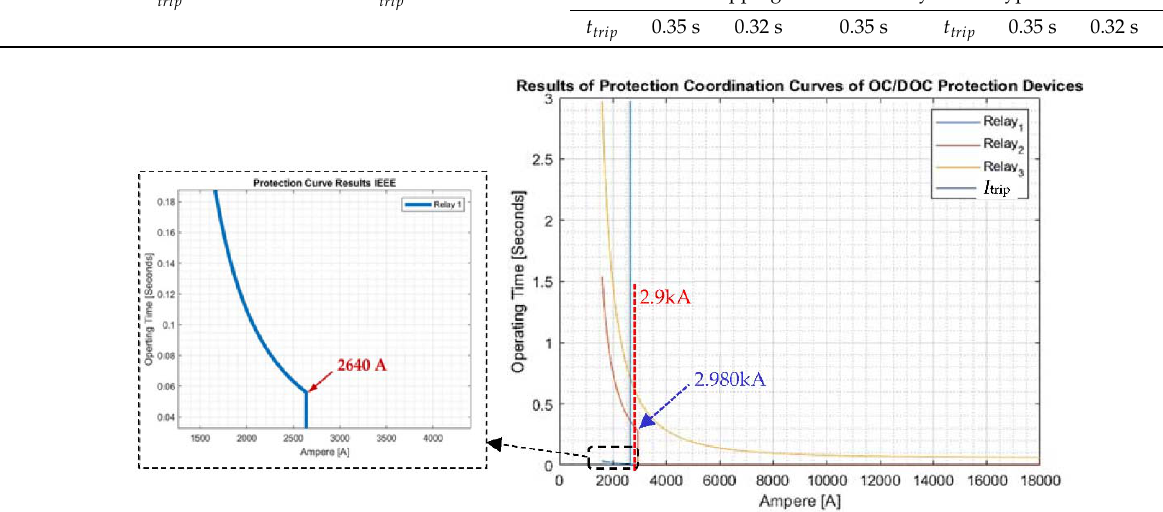
The REC Can-Thanh 163 OCR